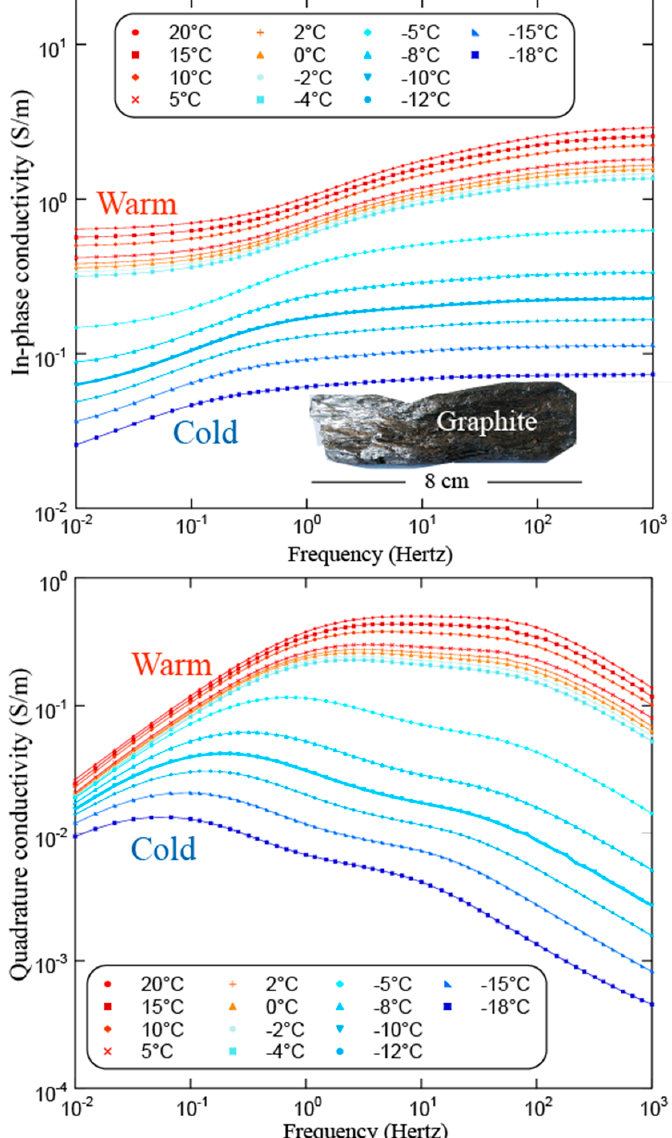
Figure 28. Results of spectral induced polarization measurements with graphite immersed in water ‐ saturated sand. Note the effect of temperature below the freezing point. Below the freezing point, the relaxation times (from the peak of the quadrature conductivity) seem to be very dependent on the temperature. Modified from [95].